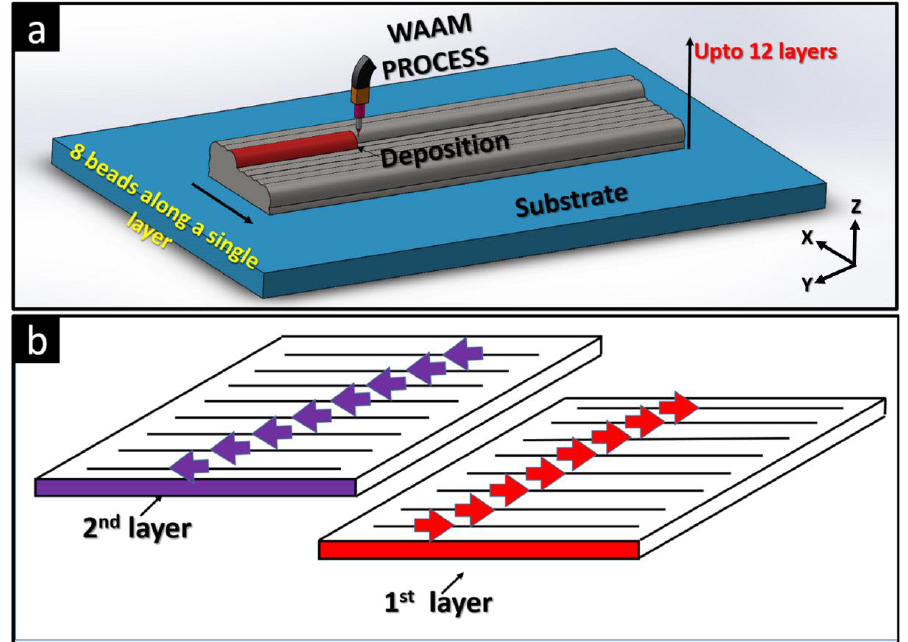
Figure 5. The ( a ) schematic representation of the process followed and ( b ) the opted scanning strategy for developing thick walls using the CMT − based WAAM process.